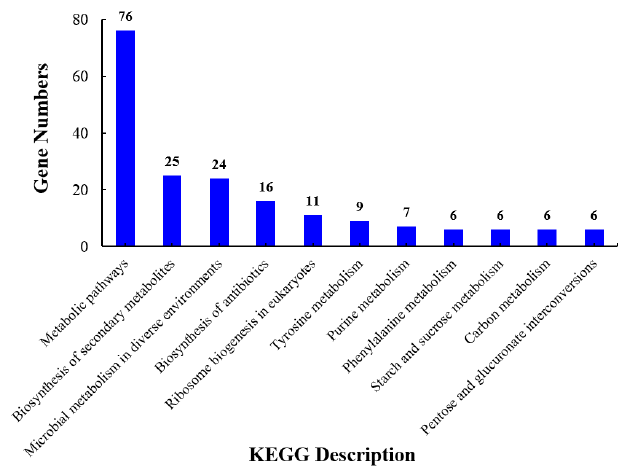
Figure 6. KEGG pathway classification of the top 11 differentially expressed genes.